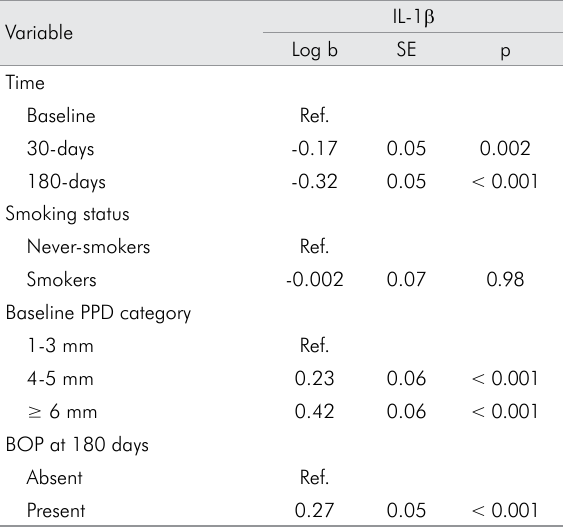
Table 2. Multivariate GEE model of the effect of the time, smoking status, baseline PPD values and BOP at the 180-day examination on the log concentration of IL-1 β .